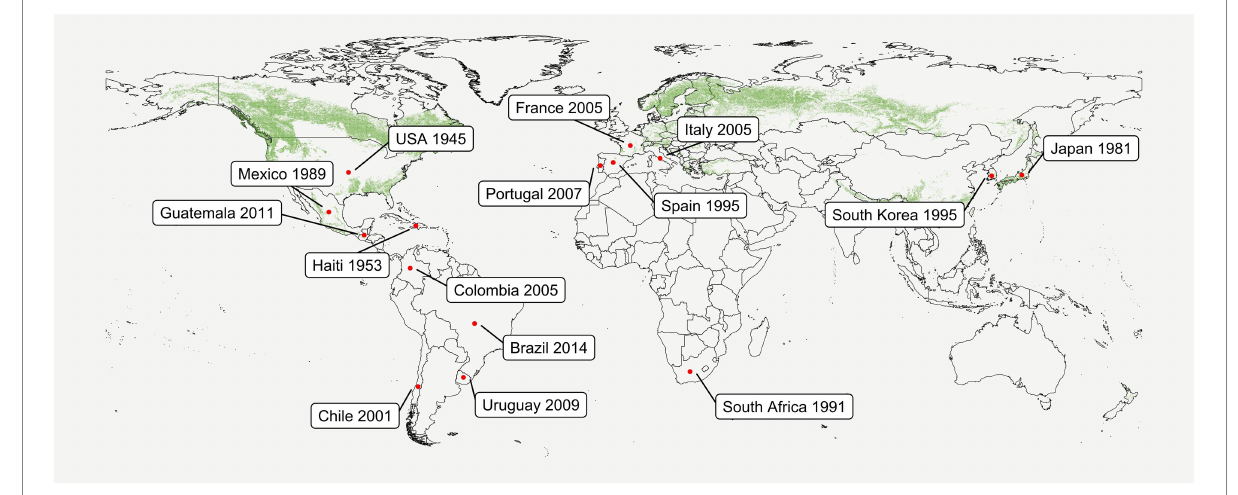
FIGURE 1 Conifer forest distribution and first reports of Fusarium circinatum worldwide. Green dots represent evergreen, deciduous, and mixed needle forests (min. area of 1 km 2 ) according to the Corine Land Cover (CLC) 2012 v. 2020_20u1 provided by the European Union Copernicus Land Monitoring Service, European Environment Agency (EEA). Red points indicate areas in which PPC has been reported and the year of the first observation. This data have been recently reviewed by Drenkhan et al. (2020), where further detail regarding the sampling site (nursery or field), identification method, and host species can be found. The report of F. circinatum in Guatemala (Dvorak et al., 2011) was also included. Databases and figures were built using R